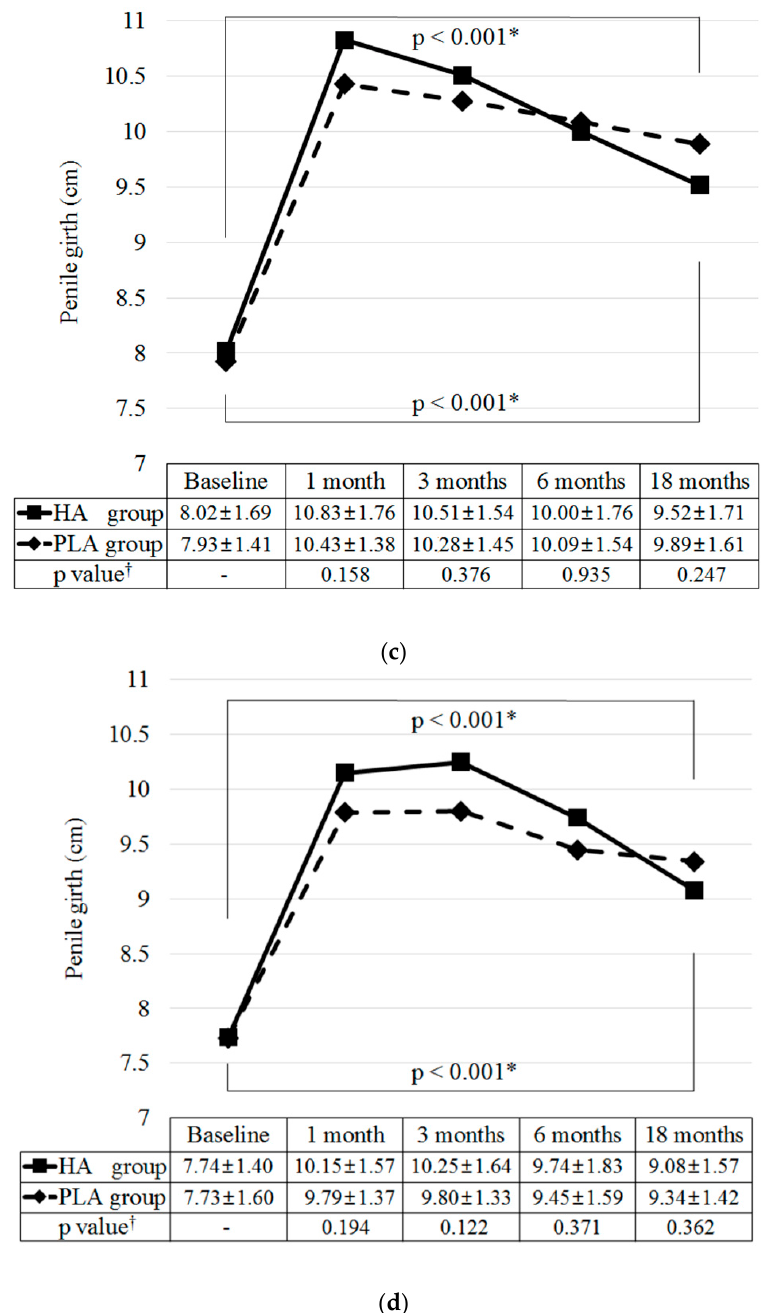
Figure 3. Changes of penile girth before and after hyaluronic acid and polylactic acid filler injections: ( a ) mean penile girth, ( b ) distal shaft, ( c ) mid-shaft, ( d ) proximal shaft. The mean penile girth was defined as the mean of the circumference measures on distal, mid-, and proximal shafts. * Paired t-test. † Injected filler volume and baseline penile girth-adjusted analysis of covariance test from baseline. HA, hyaluronic acid; PLA, polylactic acid.